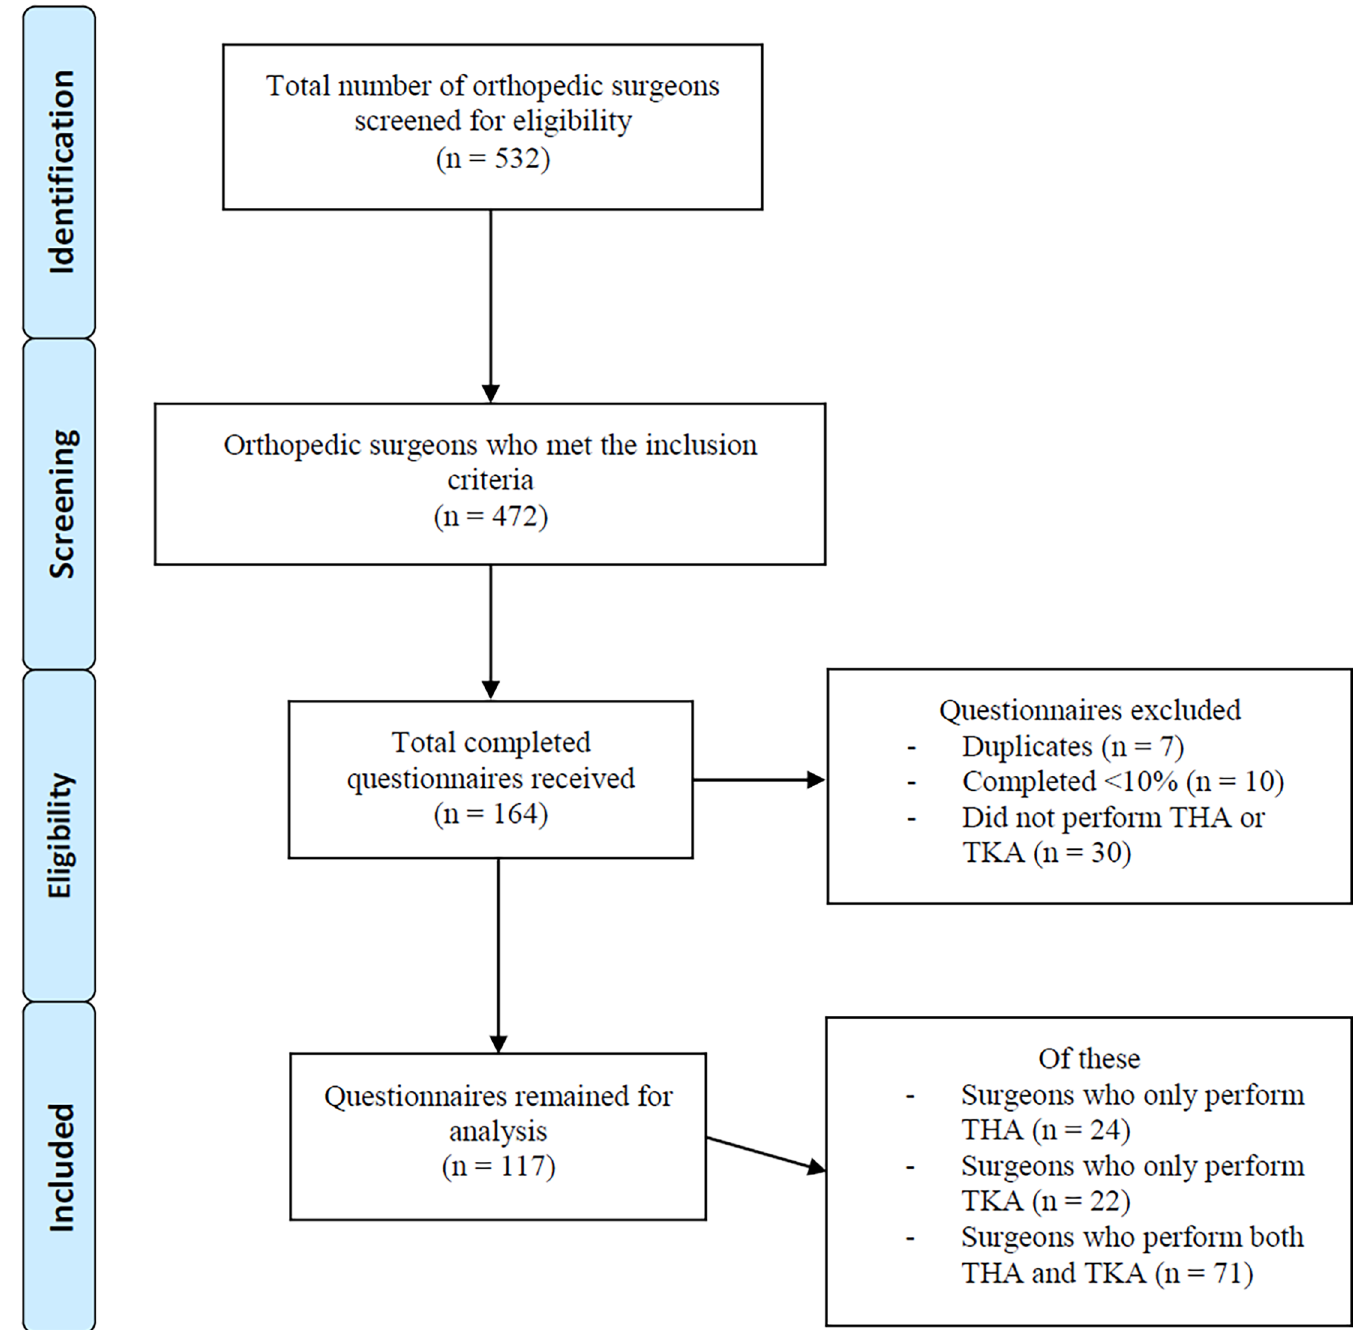
Fig 1. Flow diagram of inclusion of